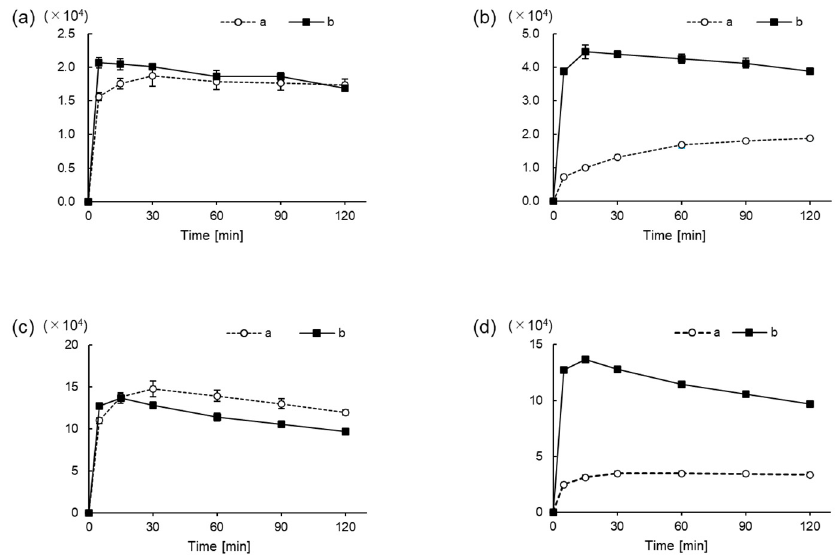
Figure 2. Time-course profiles of derivatization of amino acid: ( a ) Tau, ( b ) Glu, ( c ) Arg, and ( d ) Gln with Ns-MOK-( S )-Pro-OSu (dotted line with circles) and Ns-MOK-( S )- β -Pro-OSu (solid line with squares) by LC-TOF-MS.